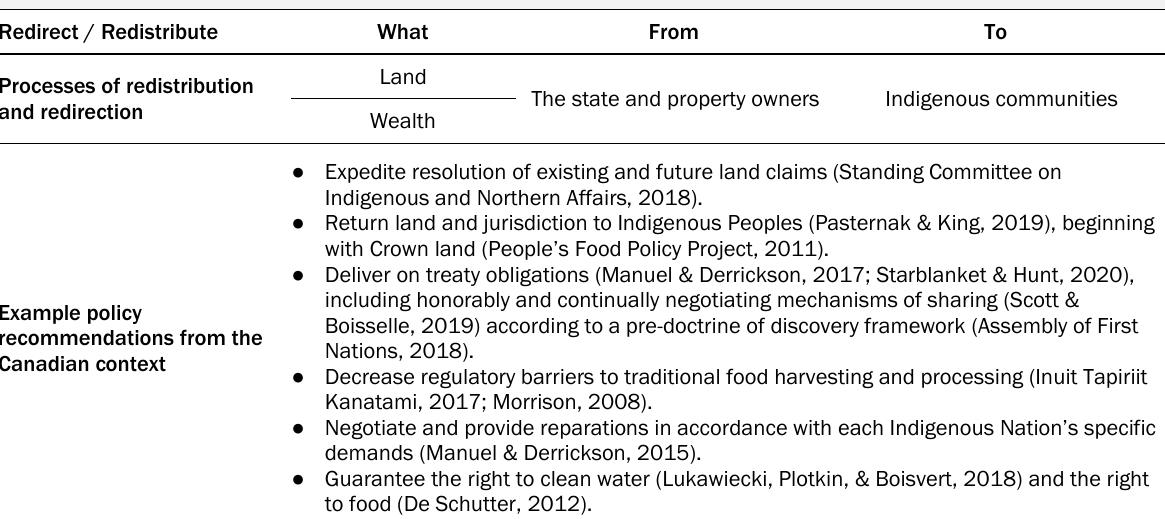
Table 1. Examples of Redistributive Policies Supporting Decolonization